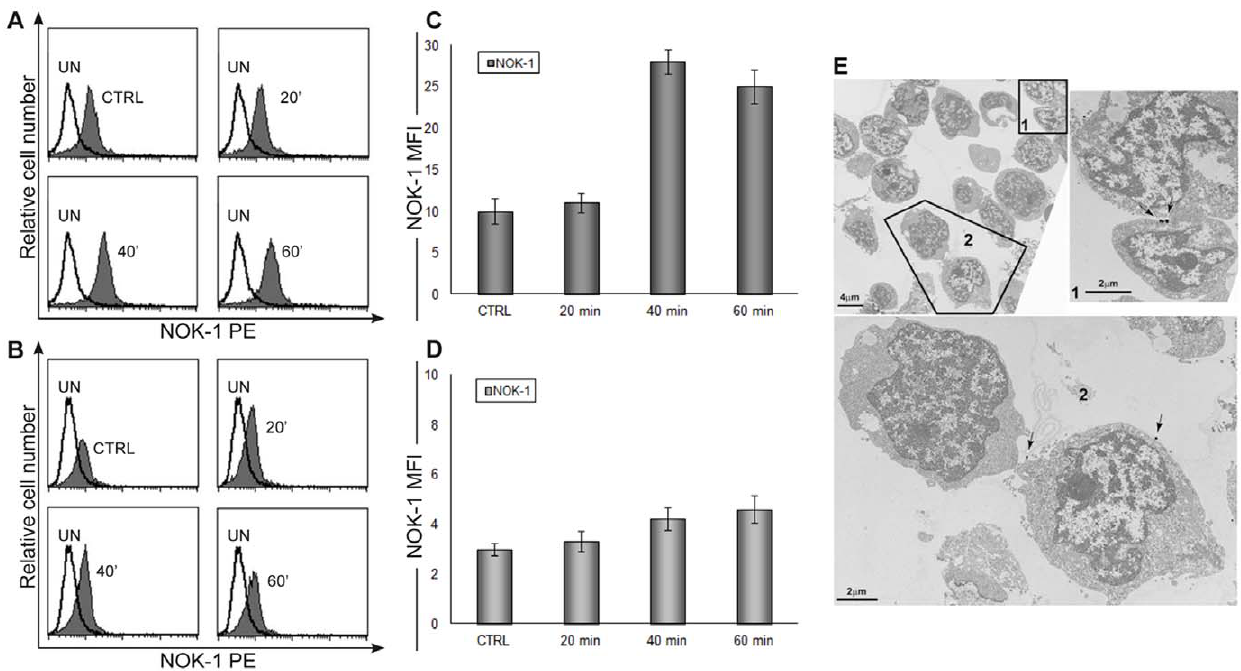
Figure 7. Detection of intracytoplasmic and surface FasL by a mAb anti-FasL NOK-1. Flow cytometric analysis of intracytoplasmic (A) and surface (B) NOK-1 PE stain of CD4 + T cells at different time points of CH-11 treatment (20 9 , 40 9 and 60 9 ). The treated histograms are compared to untreated (CTRL) and unstained (UN) samples. The statistical histograms (C,D), relating to previous cytometric data, are the mean 6 SD from 3 separate experiments. The intracytoplasmic NOK-1 PE stain (A,C) show a strongly increase after 40 min of CH-11 treatment, if compared to NOK-1 surface detection (B,D), where the MFI values are similar to all time points. The trend of the intracytoplasmic detection indicated a FasL mobilization. Immunoelectron microscopy (E) of FasL distribution in cell couplings by NOK-1 stain. Magnified views (1,2) demonstrate FasL labelling in the surface and contact areas, indicated by the arrows. The panel shows a representative image of immunogold labelling that was obtained as detailed in the Materials and Methods